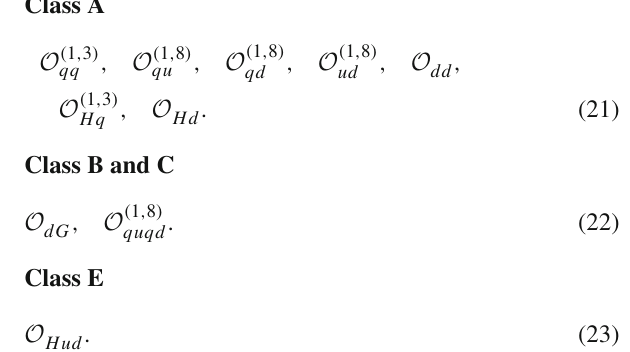
matching contributions from SMEFT due to four-quark operators and modified right-handed W ± couplings for dimension-six operators at tree level (second